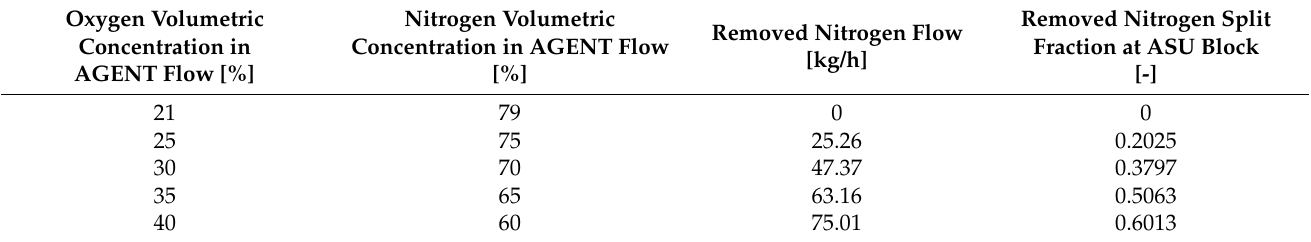
Table 3. Oxygen concentration in AGENT flow and nitrogen fractions removed in ASU block.